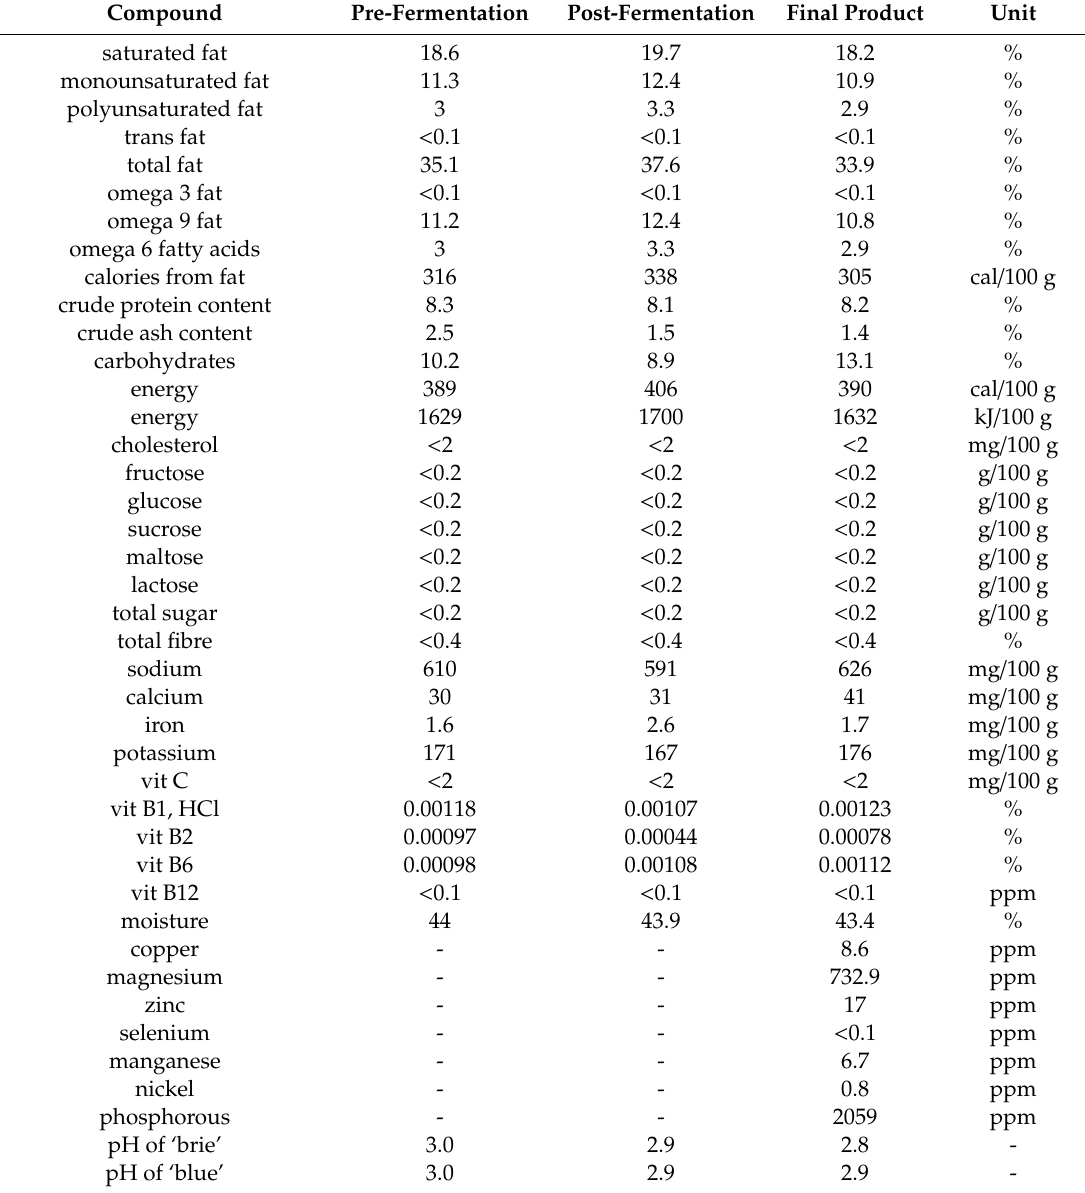
Table 1. Nutritional compounds and pH analyzed from fermented cashew cheese ‘brie’ samples at three time points (pre-fermentation, post-fermentation, final